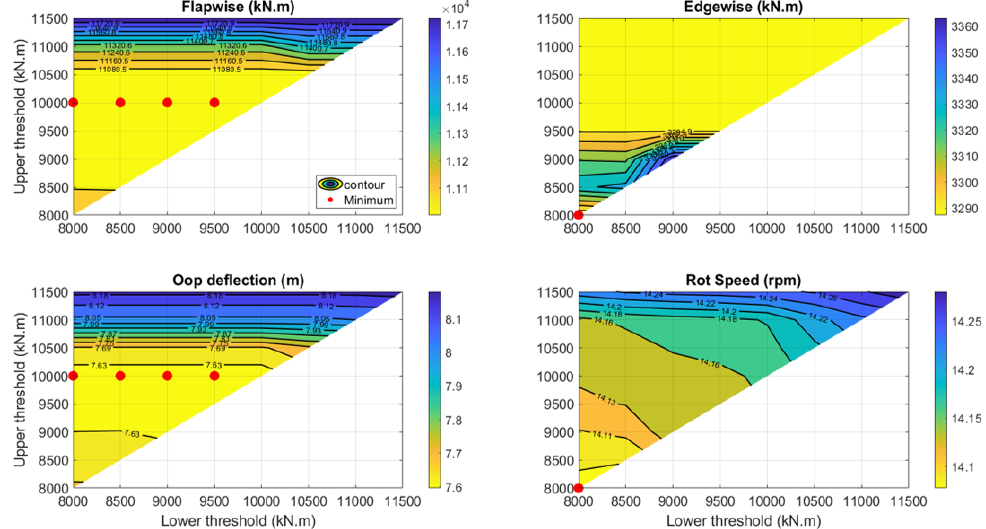
Figure 9. Contour plots for peak values of the primary evaluation